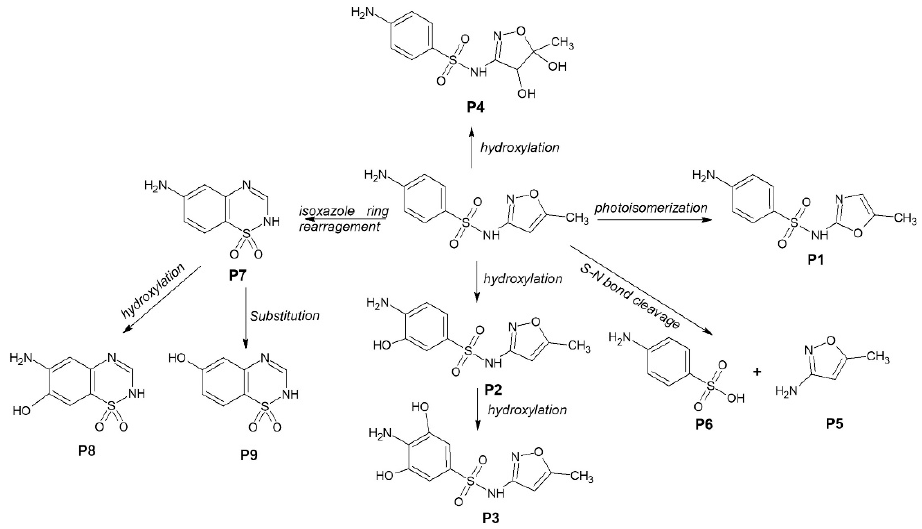
Figure 5. Proposed mechanism of SMX degradation under UVA light in the presence of anodic TiO 2 nanotube layer.